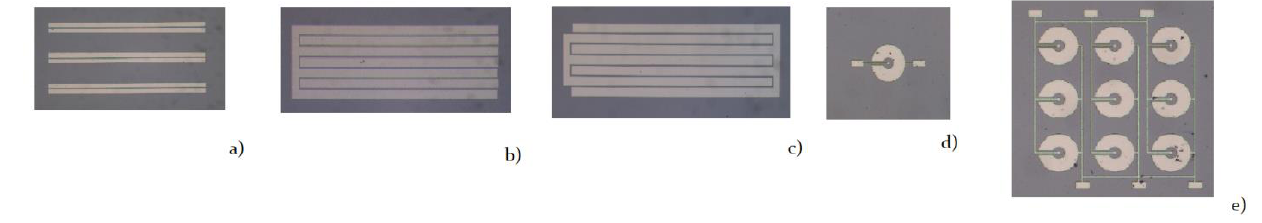
Figure 7. Lateral diode configurations: ( a ) strip detector, ( b ) comb and strip detectors (the comb is p-doped whereas the strips are n-doped), ( c ) double comb detector, ( d ) circular device (the central electrode is n-type whereas the external electrode is p-type, ( e ) 3 × 3 array of circular detectors.